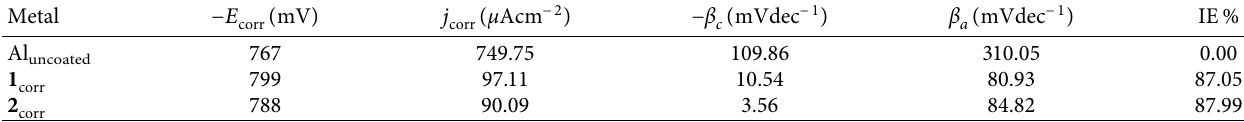
Table 5: Polarization parameters for coated and uncoated aluminium in 1.0M hydrochloric acid.